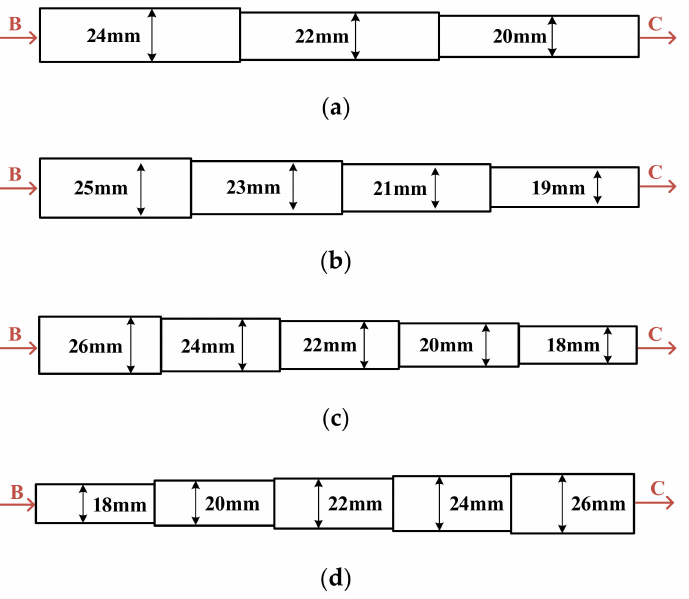
Figure 7. Structure of nonlinear variable cross-section stator ventilation hole. ( a ) scheme 1; ( b ) scheme 2; ( c ) scheme 3; ( d ) scheme